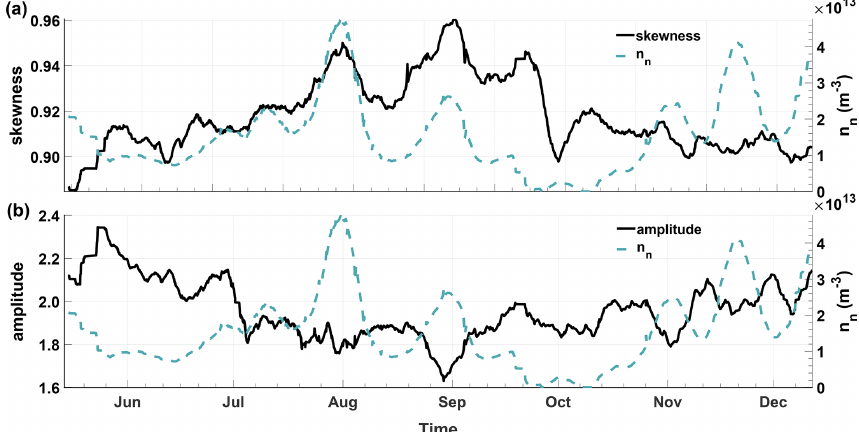
Figure 9. Averaged skewness and neutral gas density from 14 May to 12 December 2015 (a) . In (b) the averaged amplitude and neutral gas density are shown. While the skewness exhibits a clear correlation with the neutral gas density, especially until October, the amplitude is mostly anti-correlated to the neutral gas